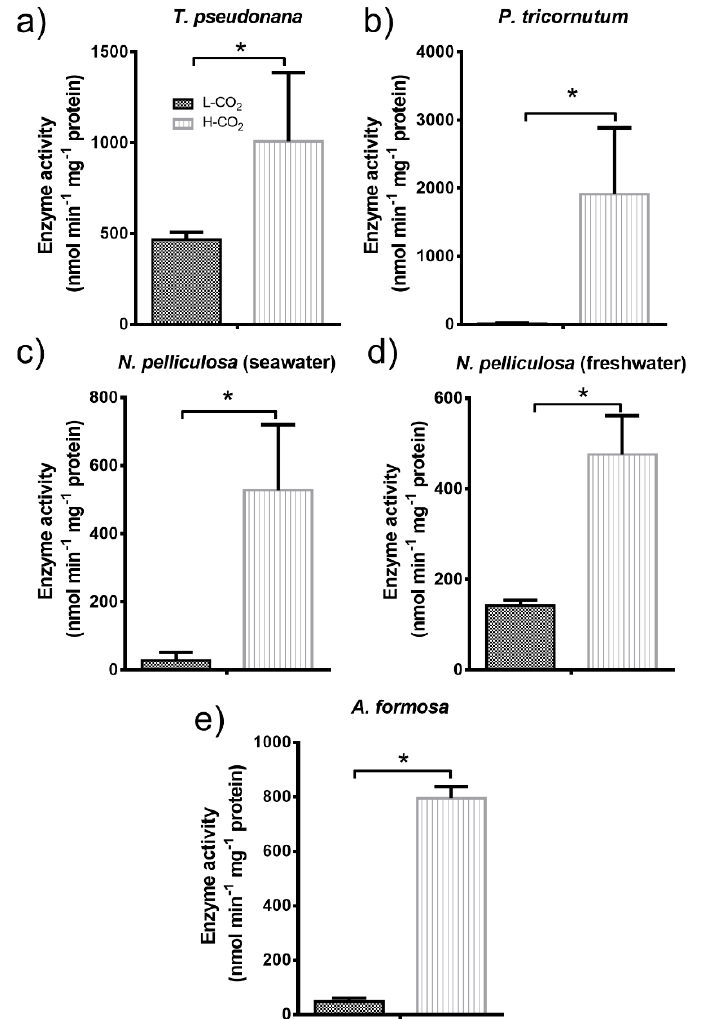
Figure 6. Pyruvate kinase (PK) activity in diatoms ( a – e ) grown at low CO 2 (L-CO 2 ; 400 ppm, dark grey bars) or high CO 2 (H-CO 2 ; 20,000 ppm, light grey and dashed bars), as specified in panel ( a ). Average and error bars (SD) are represented (n = 3). * p ≤ 0.05.